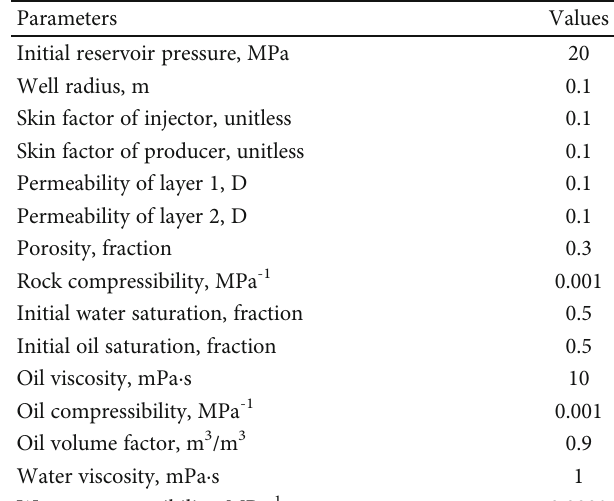
Table 1: The basic parameters of the reservoir.